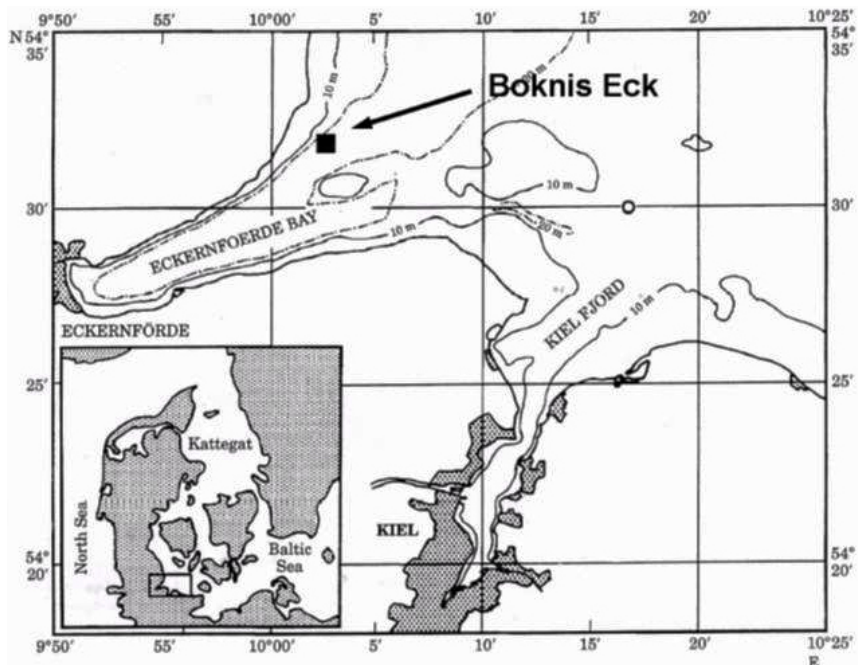
Figure 1. Location of the Boknis Eck Time Series Station in the Eckernförde Bay, southwestern Baltic Sea. (Map from Hansen et al.,